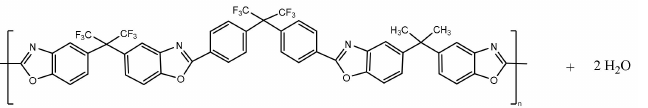
Figure 3. Result of the thermal rearrangement of HPA to HPA-TR plus water. See Figure 1 for the structure of